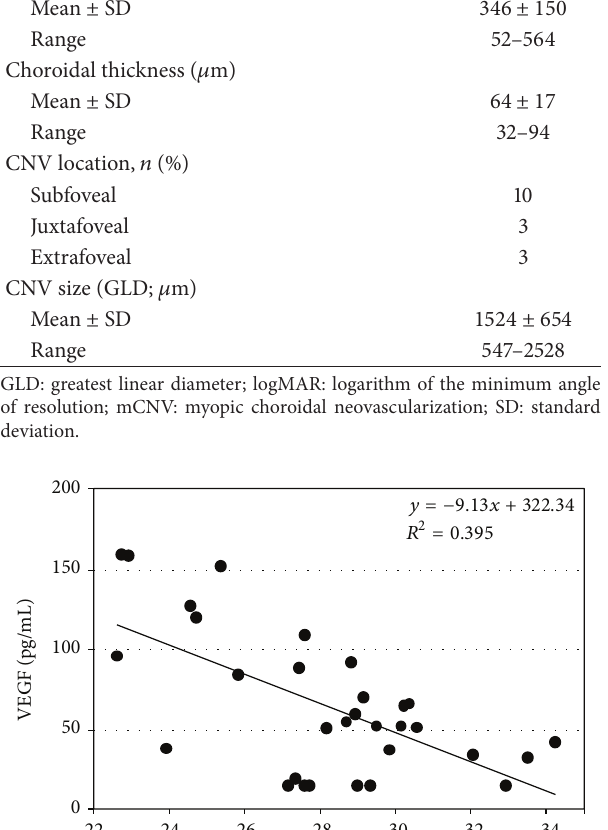
degeneration of the choroidal and retinal tissue in pathologic